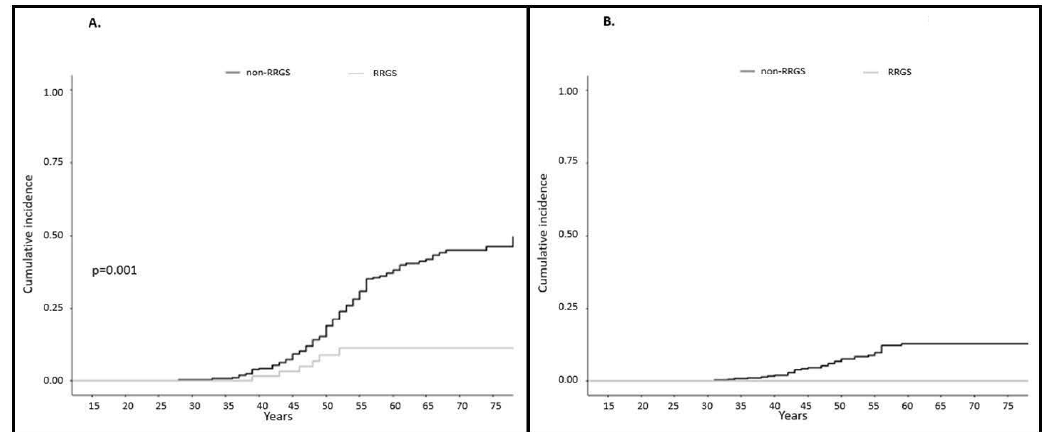
Figure 2. Cumulative incidence at 75 years of gynecological cancer in females with Lynch syndrome comparing risk reducing gynecological surgery and non-risk reducing gynecological surgery: ( A ) Cumulative incidence at 75 years of endometrial cancer. Cumulative incidence at 75 years of endometrial cancer was 11.2% for risk reducing gynecological surgery vs. 46.3% for non-risk reducing gynecological surgery ( p = 0.001); ( B ) Cumulative incidence at 75 years of ovarian cancer. Cumulative incidence at 75 years of ovarian cancer was 0.0% for risk reducing gynecological surgery vs. 12.7% for non-risk reducing gynecological surgery ( p = not assessable).